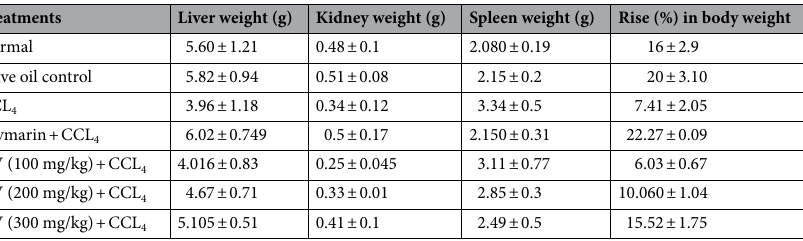
Table 1. Protective effect of methanol extract of Dodonaea Viscosa flowers. Results were expressed in triplicate manner with mean ± SD.